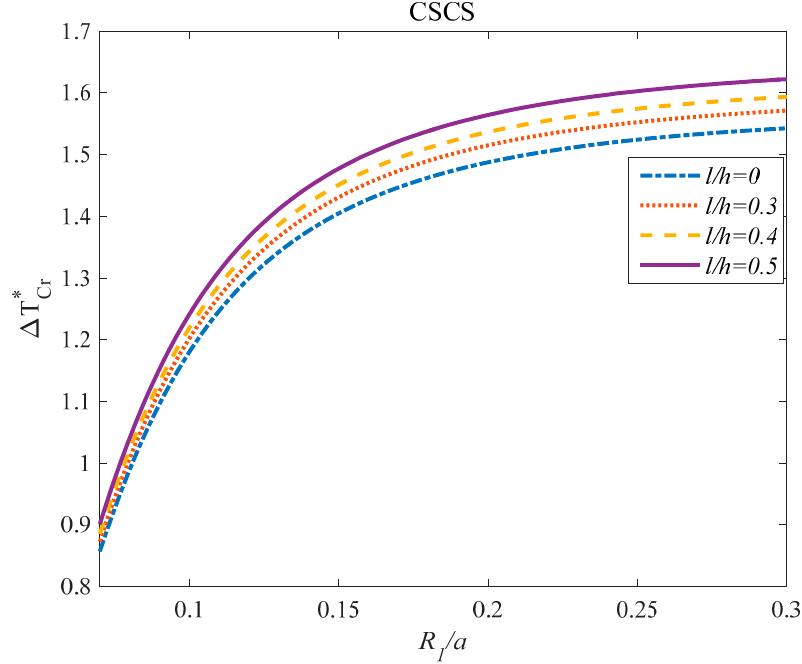
Figure 14. The e ff ects of l / h and R 1 / a parameters on the critical temperature of the GPLRC panel Figure 14. The effects of l/h and 𝑅 (cid:2869) /𝑎 parameters on the critical temperature of the GPLRC panel subjected to CSSS boundary conditions (b/a = 4, h = a/10, R2 = 5b, N L = 10, 𝜇 (cid:3404) ℎ/10 , 𝑔 (cid:3008)(cid:3017)(cid:3013) =1%, and subjected to CSSS boundary conditions (b / a = 4, h = a / 10, R2 = 5b, N L = 10, µ = h /10, g GPL = 1%, GPL ‐ O). and